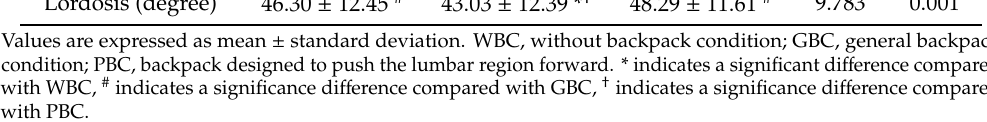
Table 3. Comparison of lumbar alignment according to backpack carriage and type.